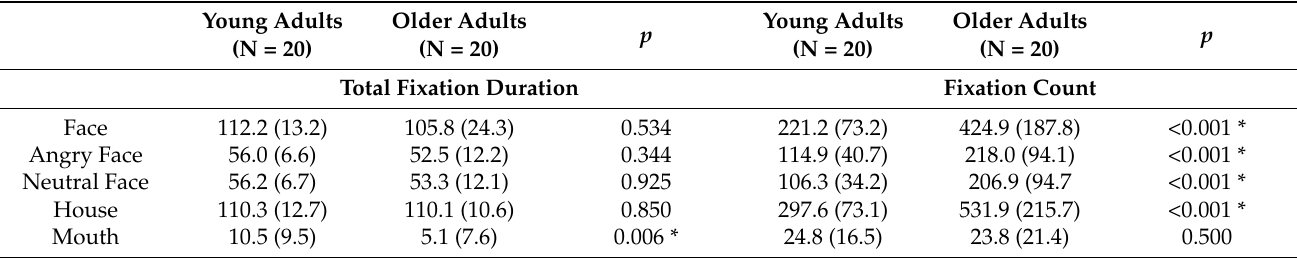
Table A1. Overview of eye-tracker